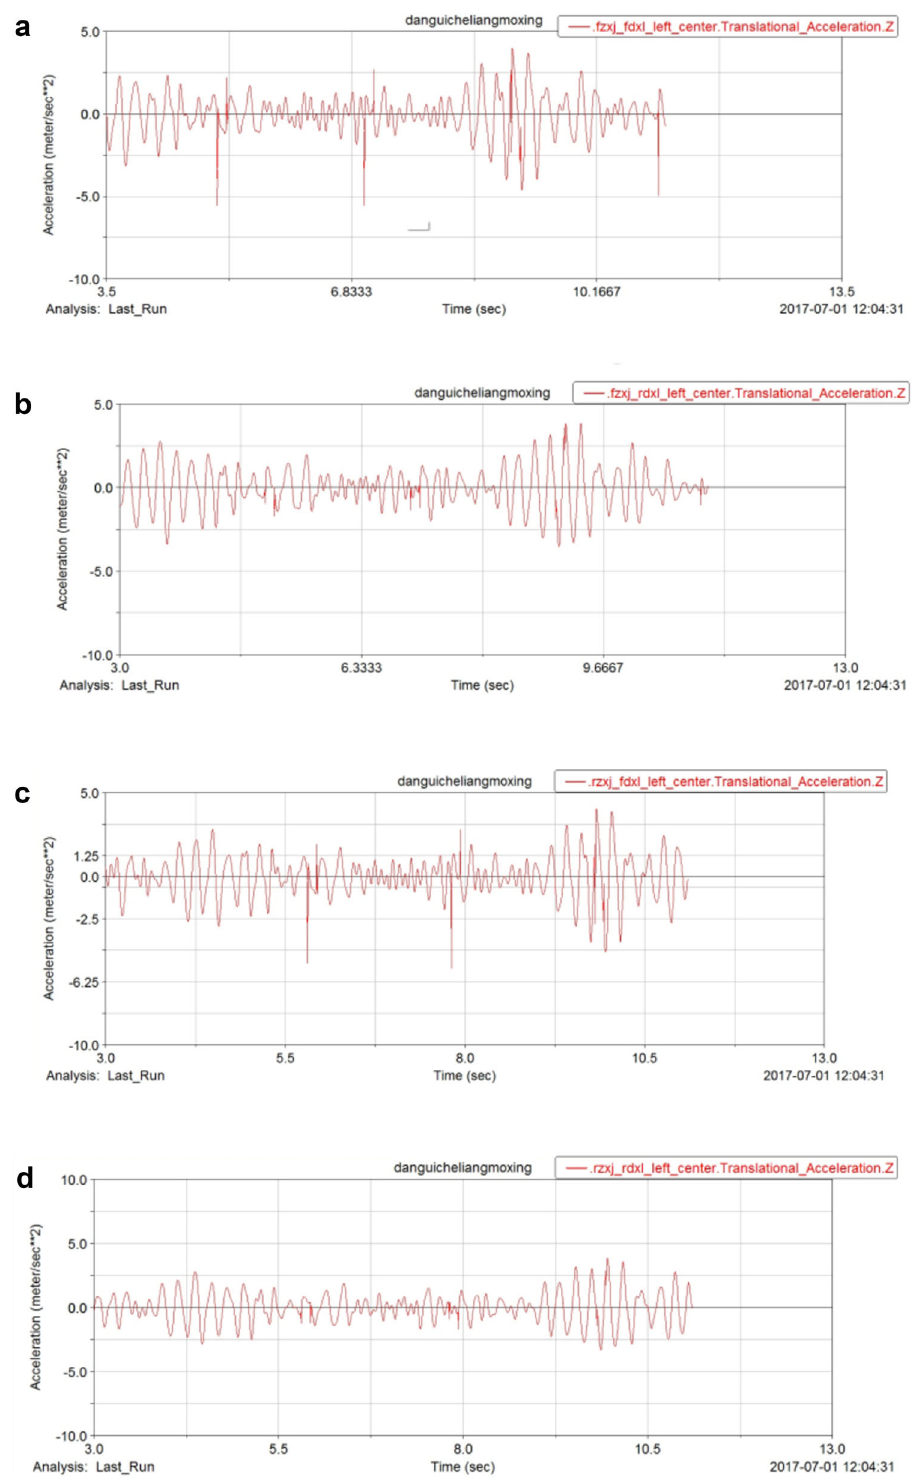
Fig. 4 Movement of the four bogies in time domain. a Vertical acceleration of front bogie front axle, b vertical acceleration of front bogie rear axle, c vertical acceleration of rear bogie front axle, d vertical acceleration of rear bogie